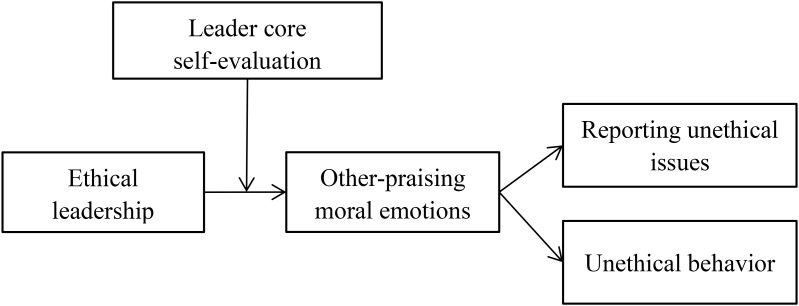
Theoretical model.